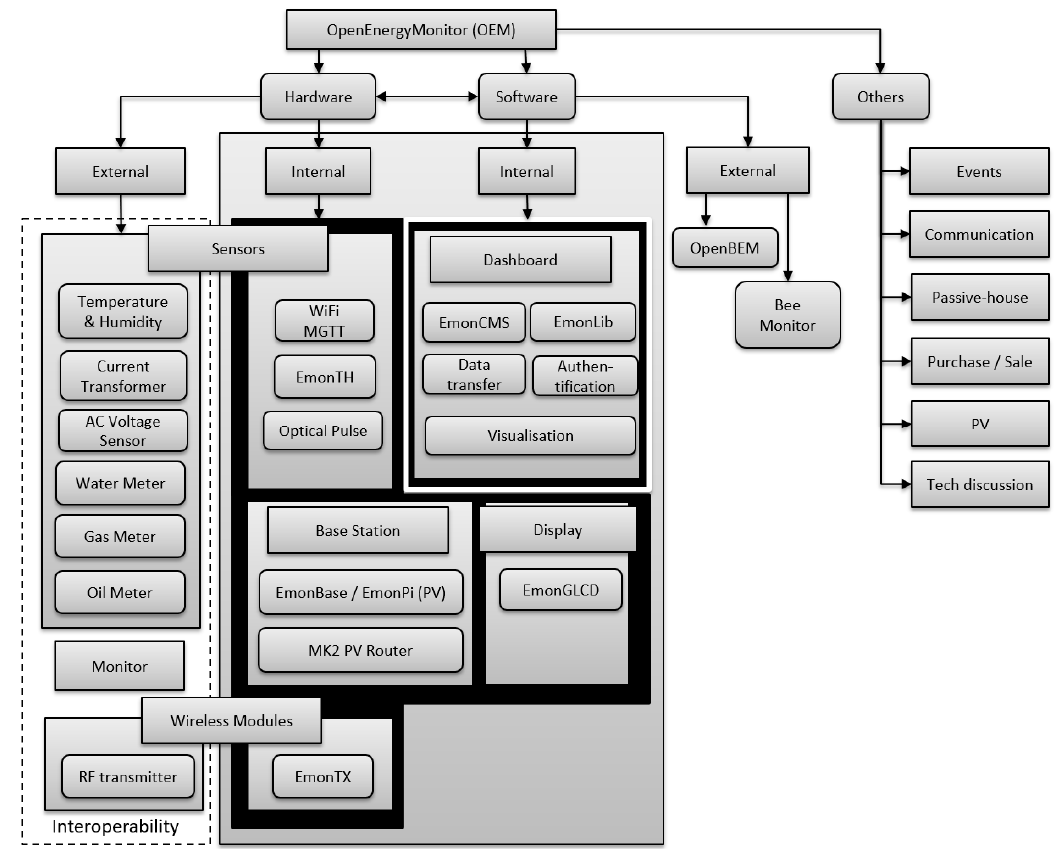
Figure 1. The OpenEnergyMonitor architecture.